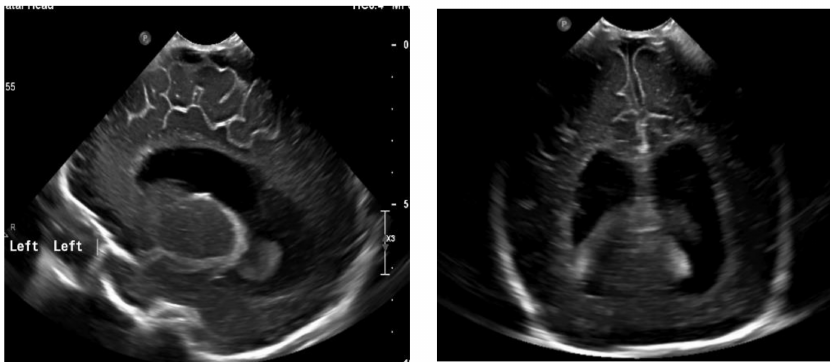
Figure 3. Normal appearance and size of the ventricles on fontanelle ultrasound.